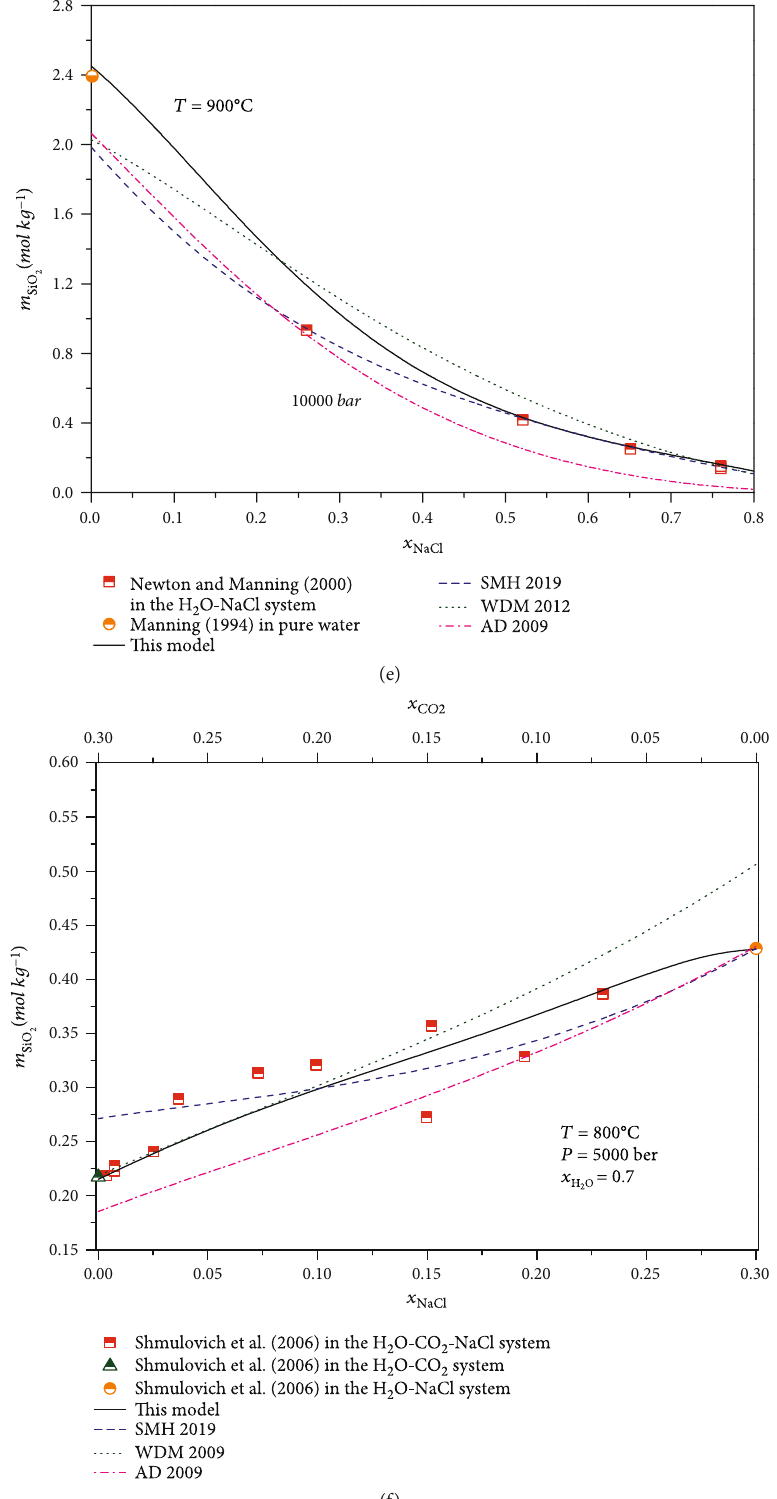
Figure 3: Model predictions of quartz solubility in (a, b) aqueous CO NaCl-bearing solutions. Di ff erent curves denote comparisons between four model computes and experimental data sets. Symbols represent experimental data, and curves are the predictions of di ff erent